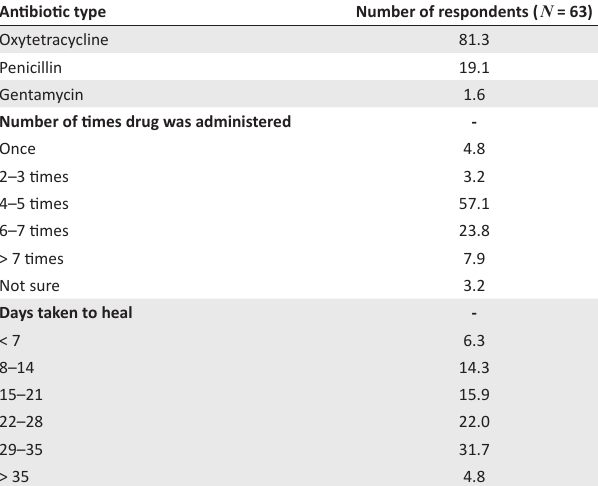
TABLE 3: Proportions ( % ) of antibiotic types used by farmers, frequency of use and apparent efficacy in treating dermatophilosis. Antibiotic